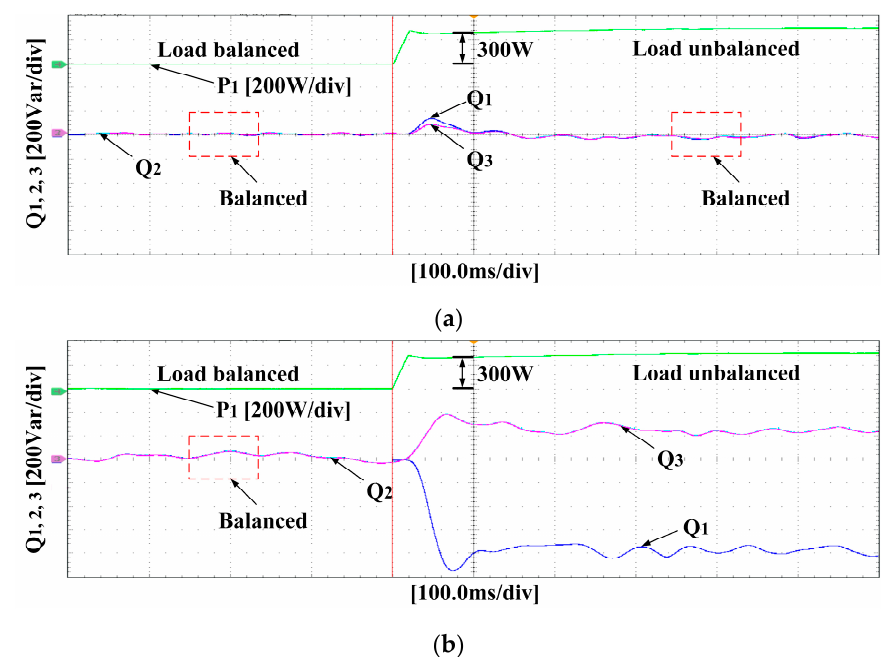
Figure 19. Experimental waveforms of the active power of the CHBR modules under load variation by use of ( a ) the proposed control strategy and ( b ) the conventional control strategy.